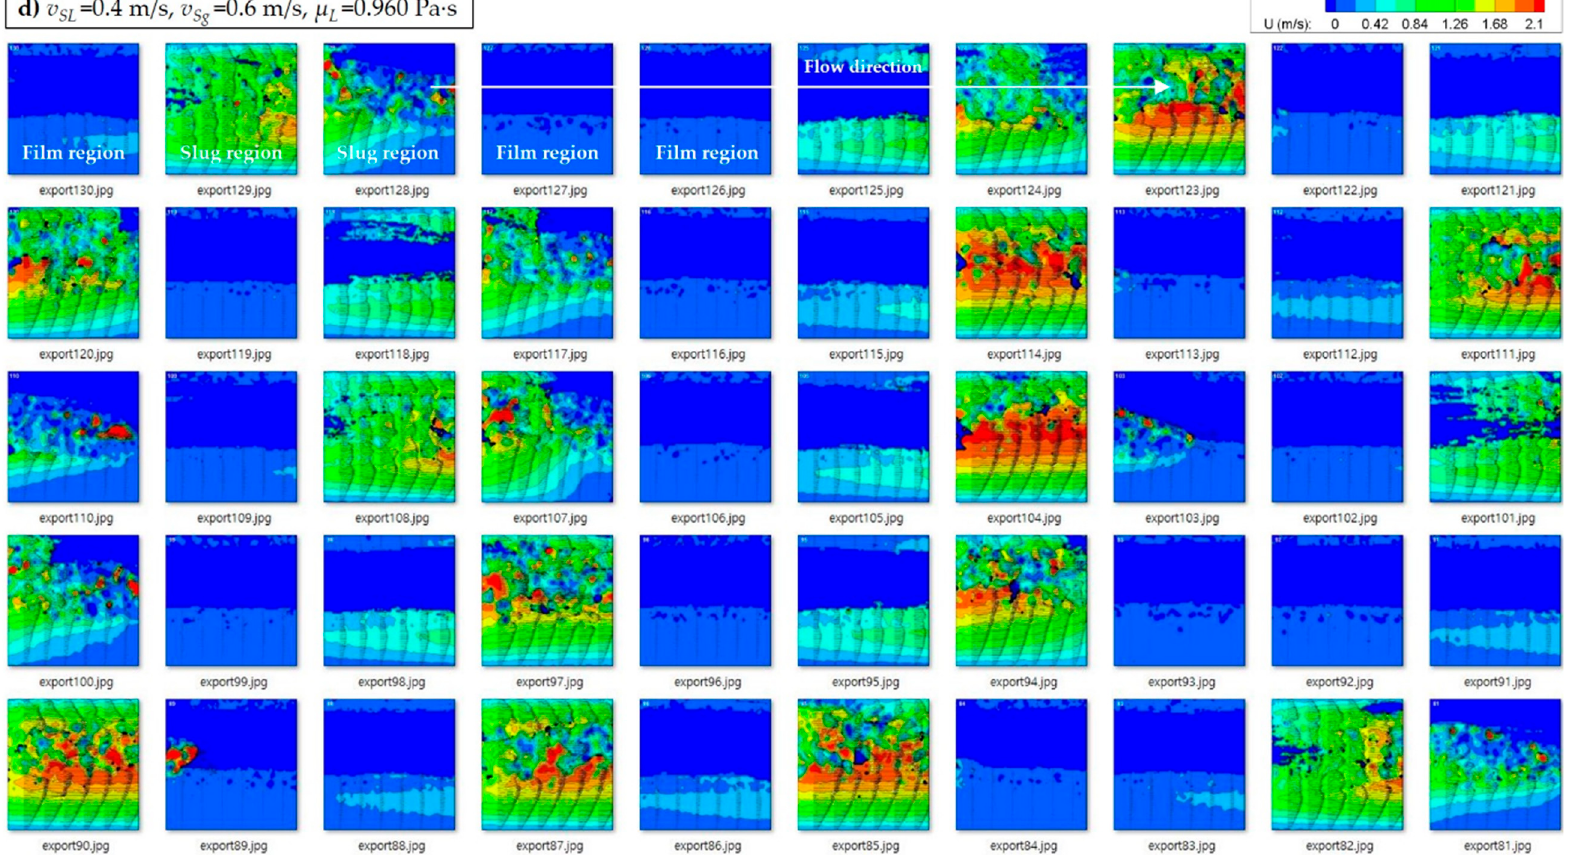
Figure 2. Velocity vector fields in axial direction with different operating conditions; ( a ) v SL = 0.2 m/s, v Sg = 0.2 m/s, μ L = 0.250 Pa ∙ s, ( b ) v SL = 0.4 m/s, v Sg = 0.6 m/s, μ L = 0.510 Pa ∙ s, ( c ) v SL = 0.2 m/s, v Sg = 0.4 m/s, μ L = 0.960 Pa ∙ s, and ( d ) v SL = 0.4 m/s, v Sg = 0.6 m/s, μ L = 0.960 Pa ∙ s [2].